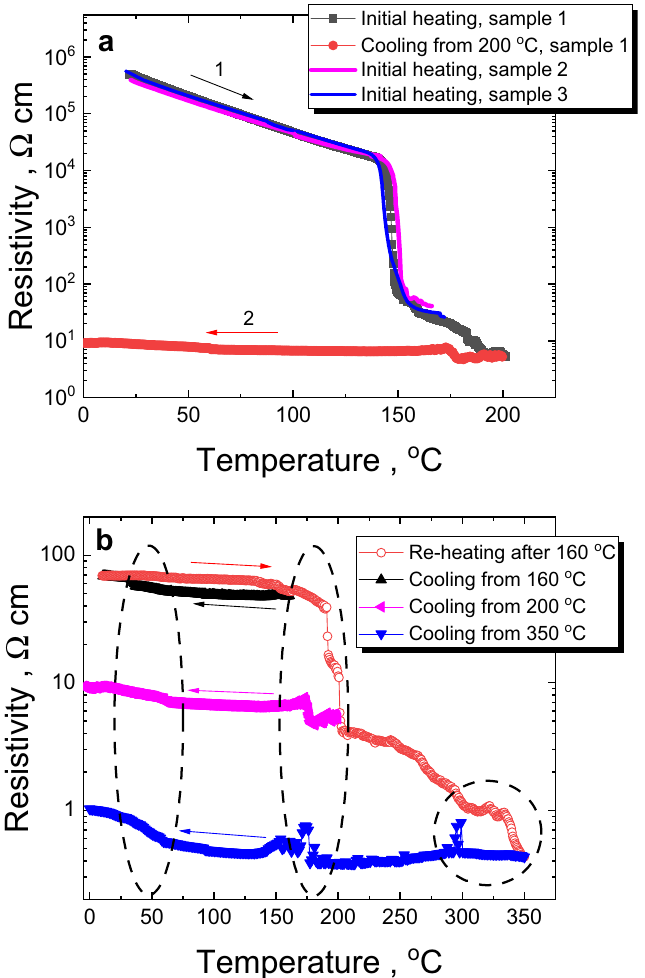
Figure 6. ( a ) Temperature dependence of resistivity measured in heating (step 1) and cooling (step 2) modes with 5 K/min rate for a fresh Ge 15 Sb 40 S 15 Se 15 Te 15 thin film, deposited on high-density Al 2 O 3 ceramic substrate with interdigitated electrodes (sample 1), shows rapid switching between High- and Low-resistivity states at ~ 145 °C. To demostrate the influence of small (within 3 at.%) variation in composition on the phase change effect, the temperature dependences of resistivity in heating mode (5 K/min) are shown for the samples 2 and 3 obtained in different synthesis using similar technique and parameters. ( b ) If the previously heated to 160 °C sample is cooled (black) and re-heated again (red) up to 350 °C, a number of features can be observed on resistivity vs temperature dependences upon heating and cooling (circled